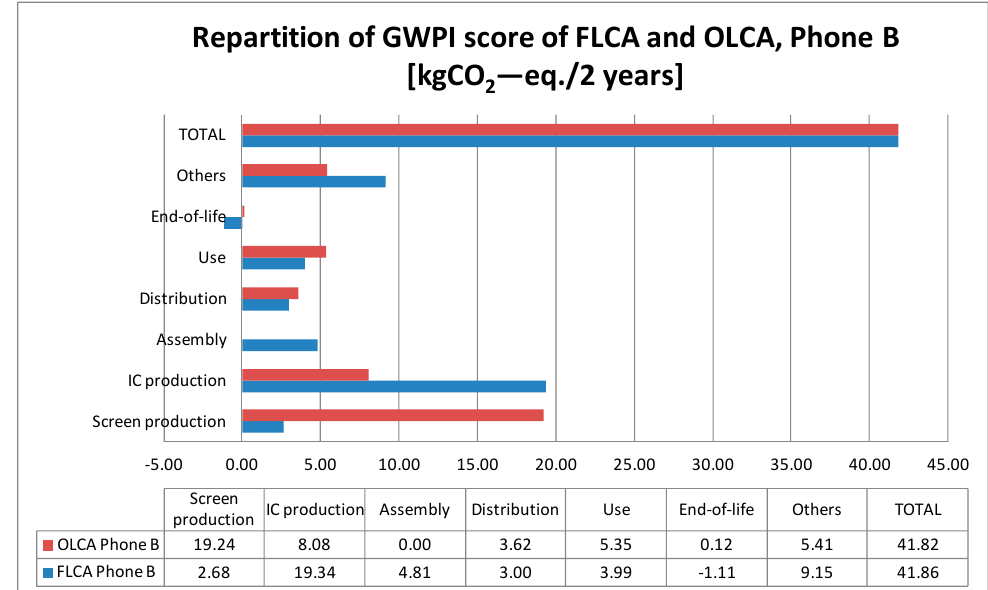
Figure 9. Repartition for FLCA and OLCA GWPI scores for Phone B.